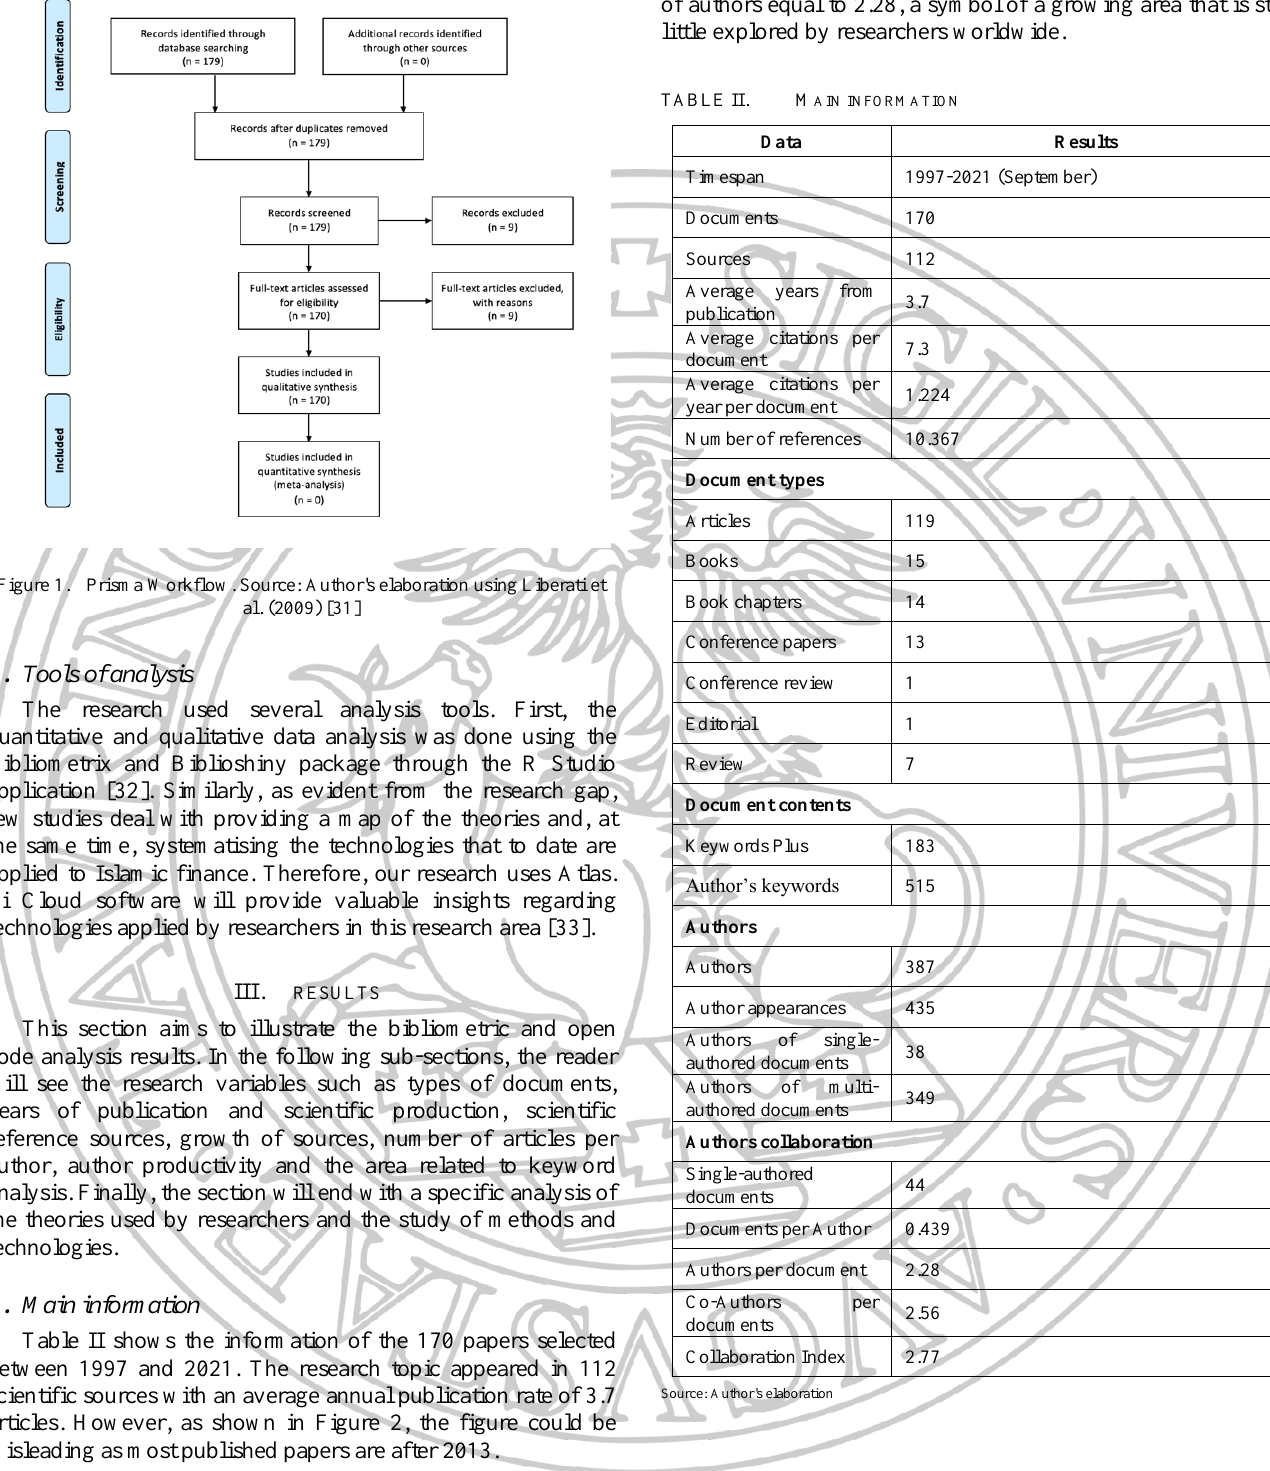
Figure 1. Prisma Workflow. Source: Author's elaboration using Liberati et al. (2009)